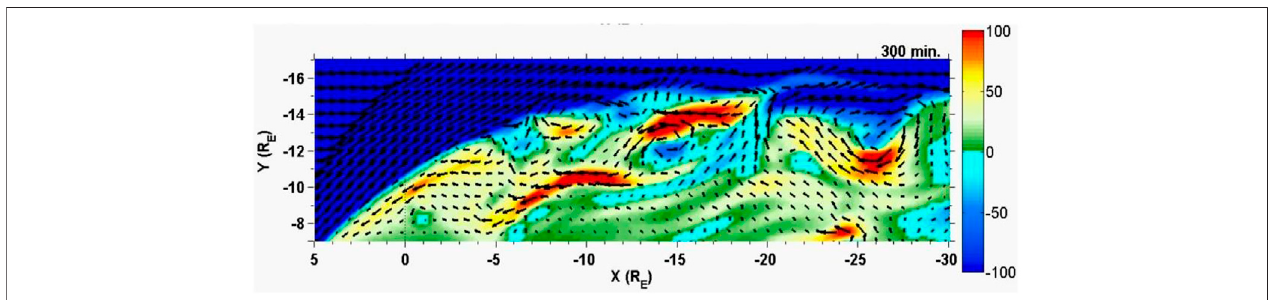
FIGURE 5 | Northward IMF results at 300 min. Shown are color contours of V x and fl ow vectors at the dawn fl ank to show the existence of waves consistent with the Kelvin-Helmholtz instability. (Adapted from El-Alaoui et al.